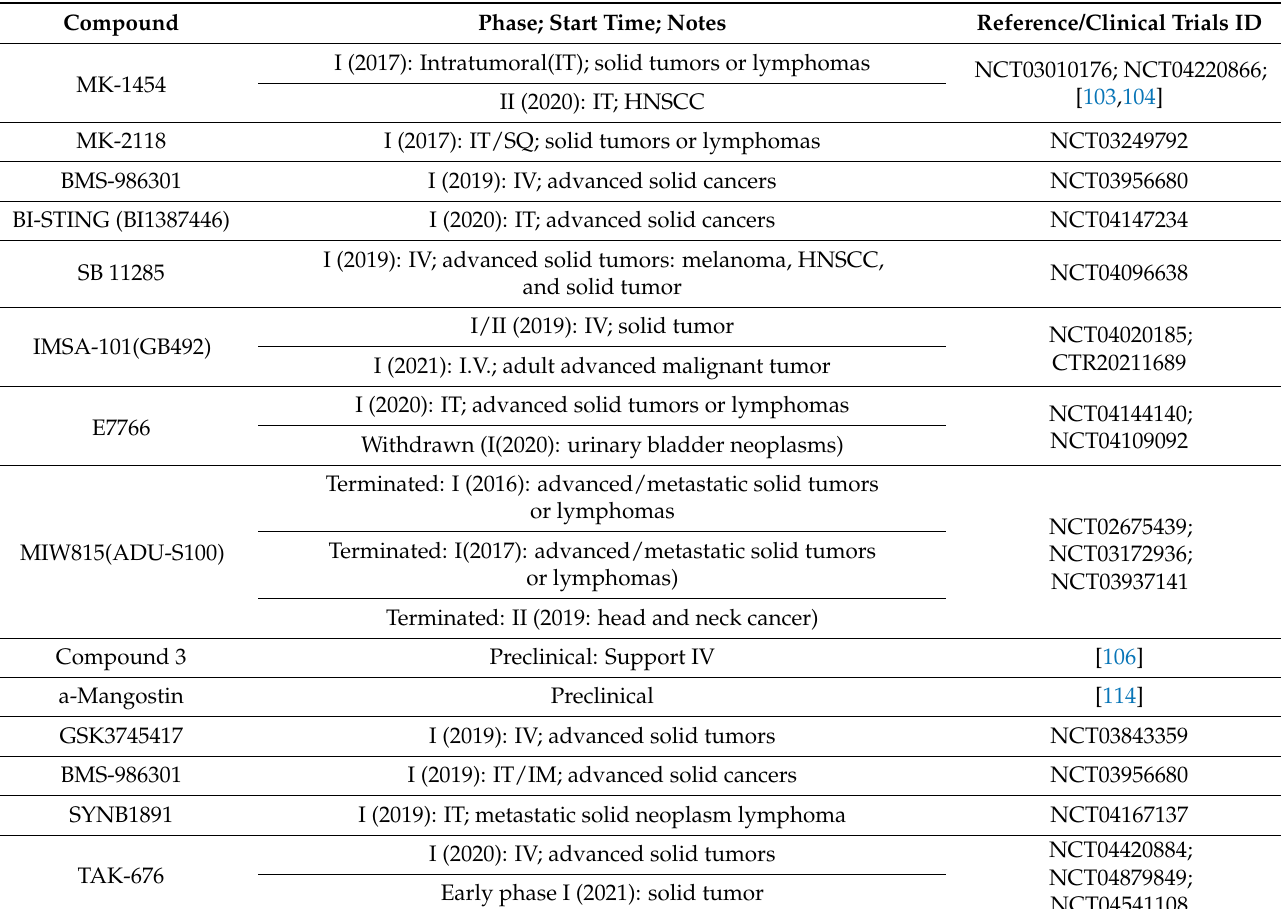
Table 2. Part of the STING agonists currently under